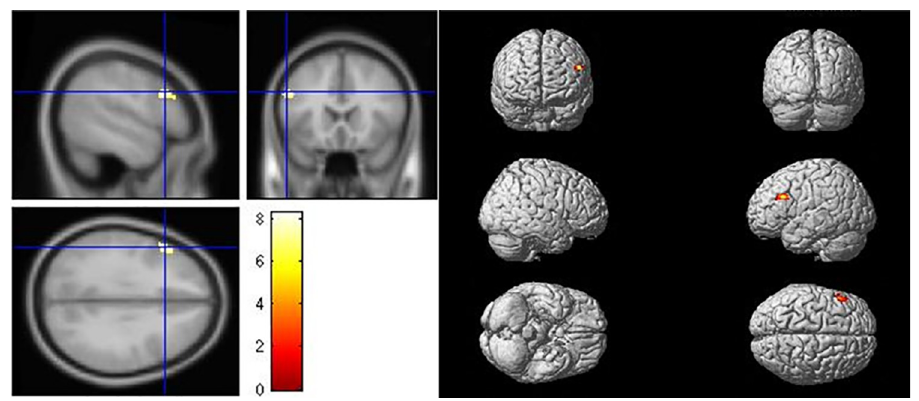
Fig 9. Brain activation for refinement (B2) versus copy drawing (A2).